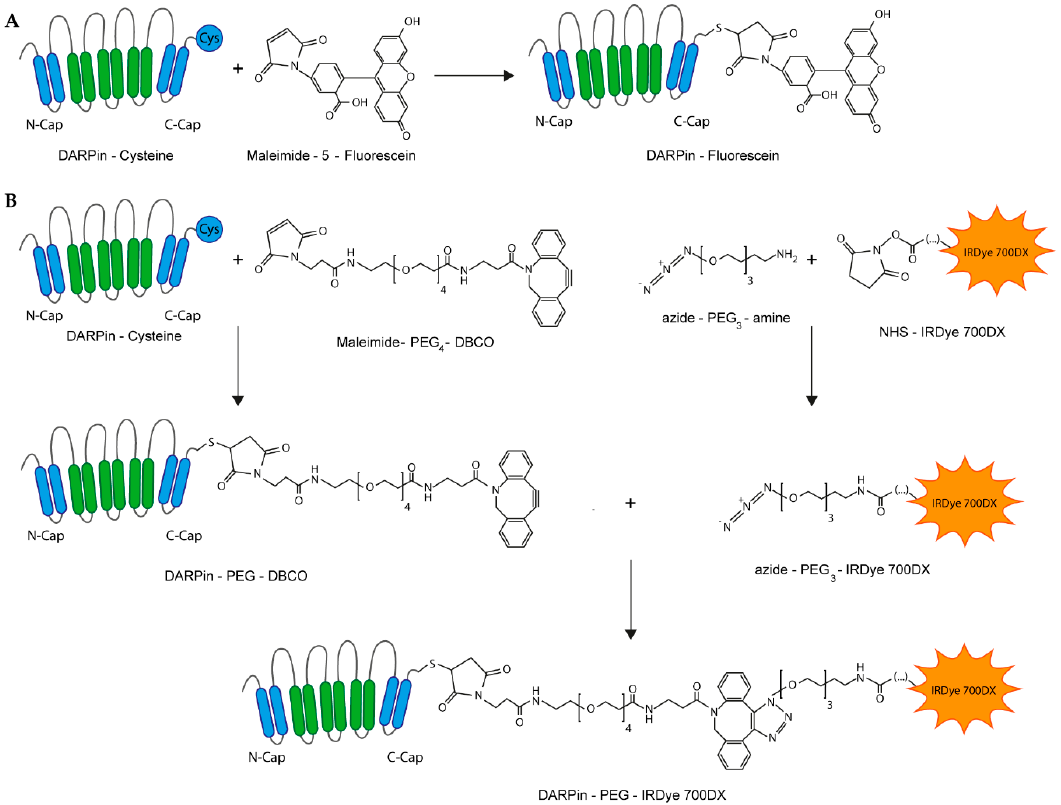
Figure 1. Schematic representation of DARPin conjugations. ( A ) Synthesis of DARPin-fluorescein conjugates. The same strategy was employed for coupling Alexa Fluor 680. ( B ) Three-step preparation of DARPin-IRDye 700DX conjugates.